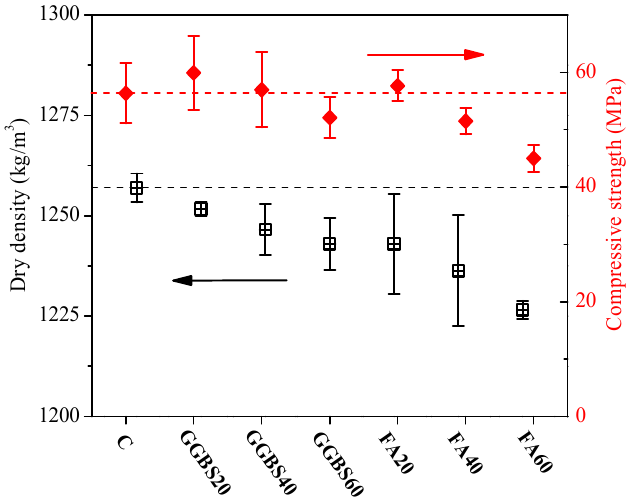
Figure 9. Density and compressive strength of seven ULHS-ECCs in the current study.